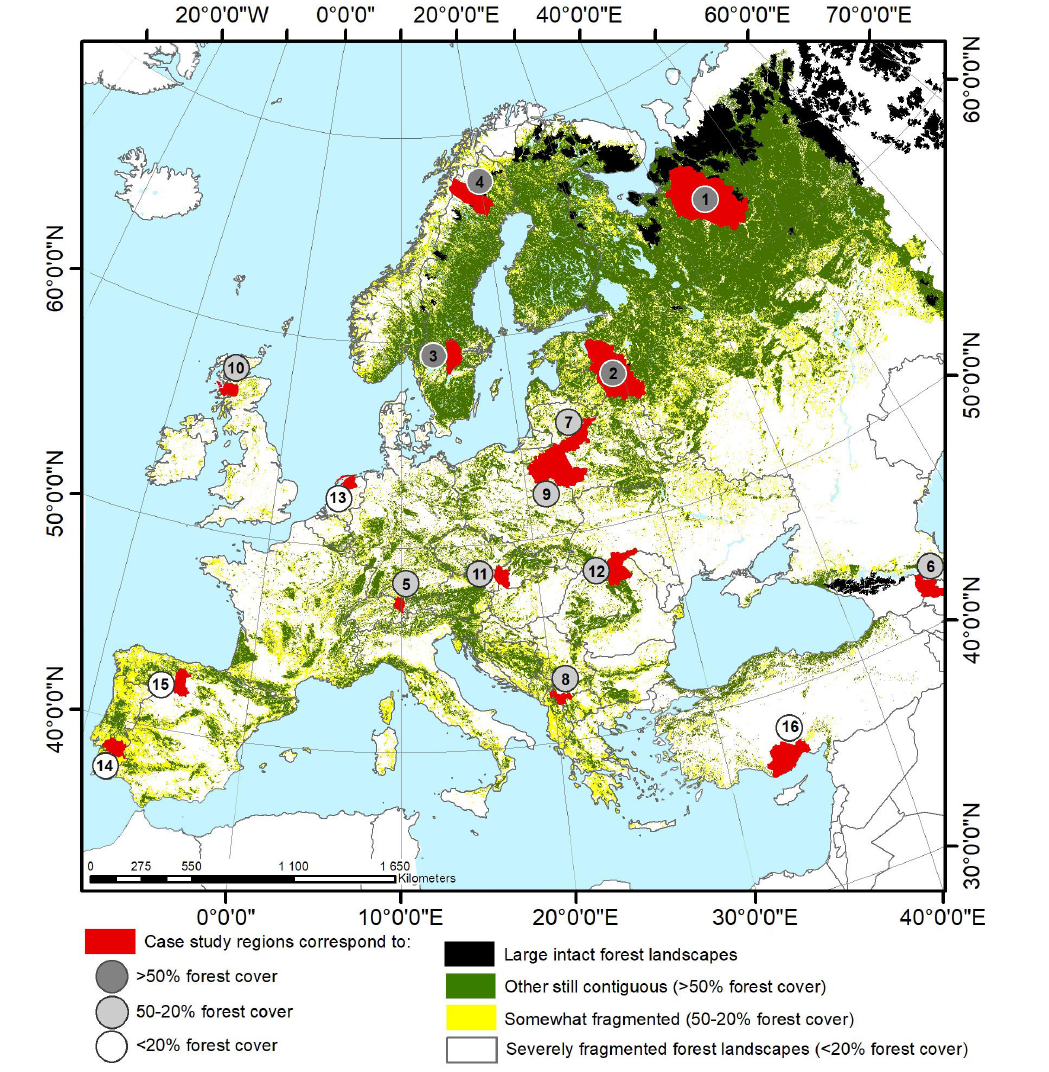
Fig. 2 . Map showing the location of 16 case study regions representing the gradient in historic forest fragmentation from intact forest landscapes (Potapov et al. 2017) via other still contiguous (> 50% forest cover), somewhat fragmented (50–20% forest cover), to severely fragmented forest landscapes (< 20% forest cover). See Table 1 for description of each case study region and constituent